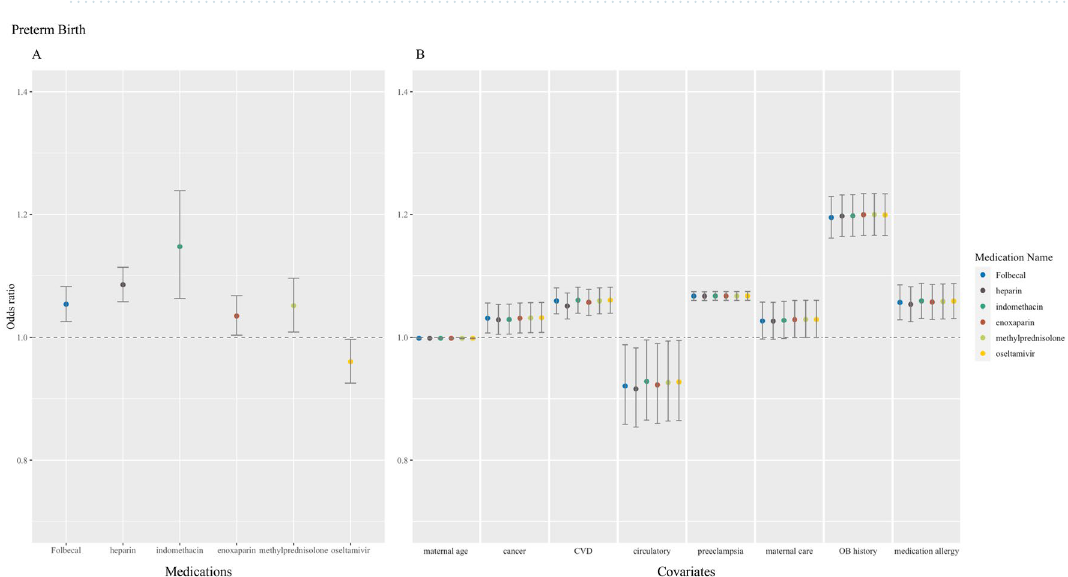
Figure 3. Medications and covariates significantly associated with preterm birth, odds ratio (95% confidence intervals). Plotted by ( A ) significant medications and ( B ) significant